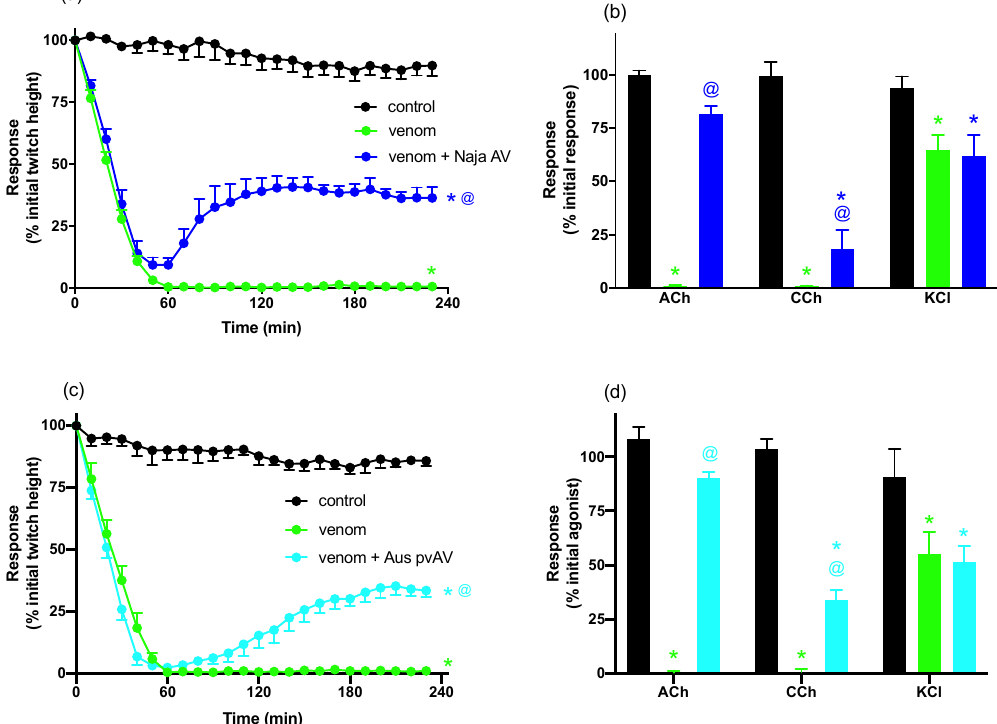
Figure 3. ( a ) The e ff ects of N. atra venom (3 µ g / mL) alone or with Naja atra antivenom (Naja AV; 0.75 U / mL) added at the t 90 time point on indirect twitches of the CBCNM. ( b ) The e ff ects of N. atra venom (3 µ g / mL) alone or with Naja AV (0.75 U / mL) added at the t 90 time point on contractile responses to ACh (1 mM), CCh (20 µ M), and KCl (40 mM) in the CBCNM. ( c ) The e ff ects of N. atra venom (3 µ g / mL) alone or with Australian polyvalent antivenom (Aus pvAV; 3 U / mL) added at the t 90 time point on indirect twitches of the CBCNM. ( d ) The e ff ects of N. atra venom (3 µ g / mL) alone or with Aus pvAV (3 U / mL) added at the t 90 time point on contractile responses to ACh (1 mM), CCh (20 µ M), and KCl (40 mM) in the CBCNM. * p < 0.05, significantly di ff erent compared to control at 230 min ( a , c ) or compared to pre-venom response to same agonist ( b , d ). @ p < 0.05, significantly di ff erent compared to venom in the absence of antivenom at 230 min ( a , c ) or compared to response to agonist in the absence of antivenom ( b , d ), n = 5–6.